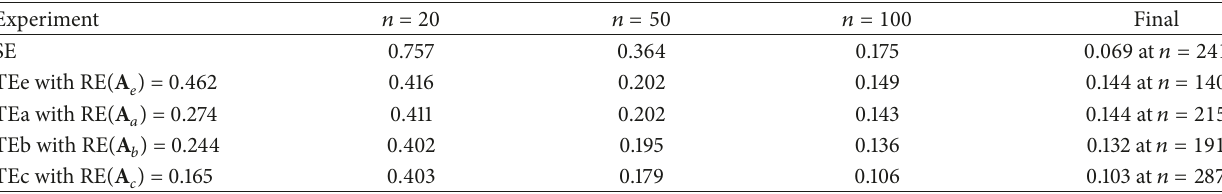
Table 4: As in Table 1 but for the two-dimensional case in Figure 10 in which the first set of two-dimensional innovations is used with periodic extension. Experiment 𝑛 = 20 𝑛 = 50 𝑛 = 100 Final SE 0.742 0.364 0.154 0.071 at 𝑛 = 201 TEe with RE( A 𝑒 ) = 0.233 0.394 0.185 0.108 0.104 at 𝑛 = 140 TEa with RE( A 𝑎 ) = 0.181 0.397 0.186 0.102 0.097 at 𝑛 = 145 TEb with RE( A 𝑏 ) = 0.130 0.403 0.183 0.089 0.085 at 𝑛 = 133 TEc with RE( A 𝑐 ) = 0.038 0.397 0.160 0.064 0.059 at 𝑛 = 183